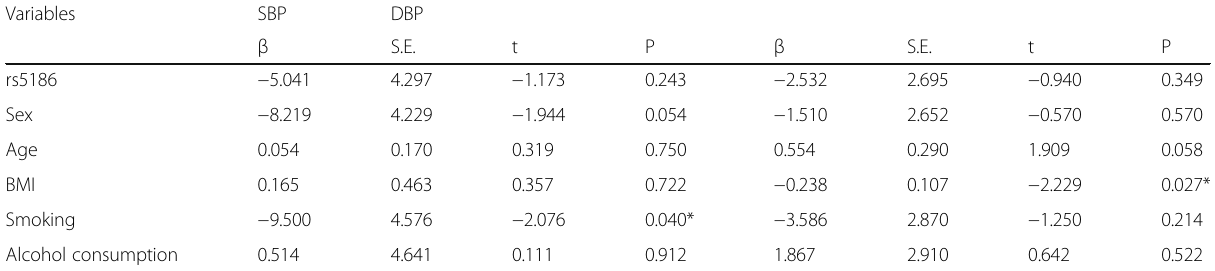
Table 8 Multivariate linear regression analysis of the rs5186 polymorphism with systolic pressure and diastolic pressure Variables SBP DBP β